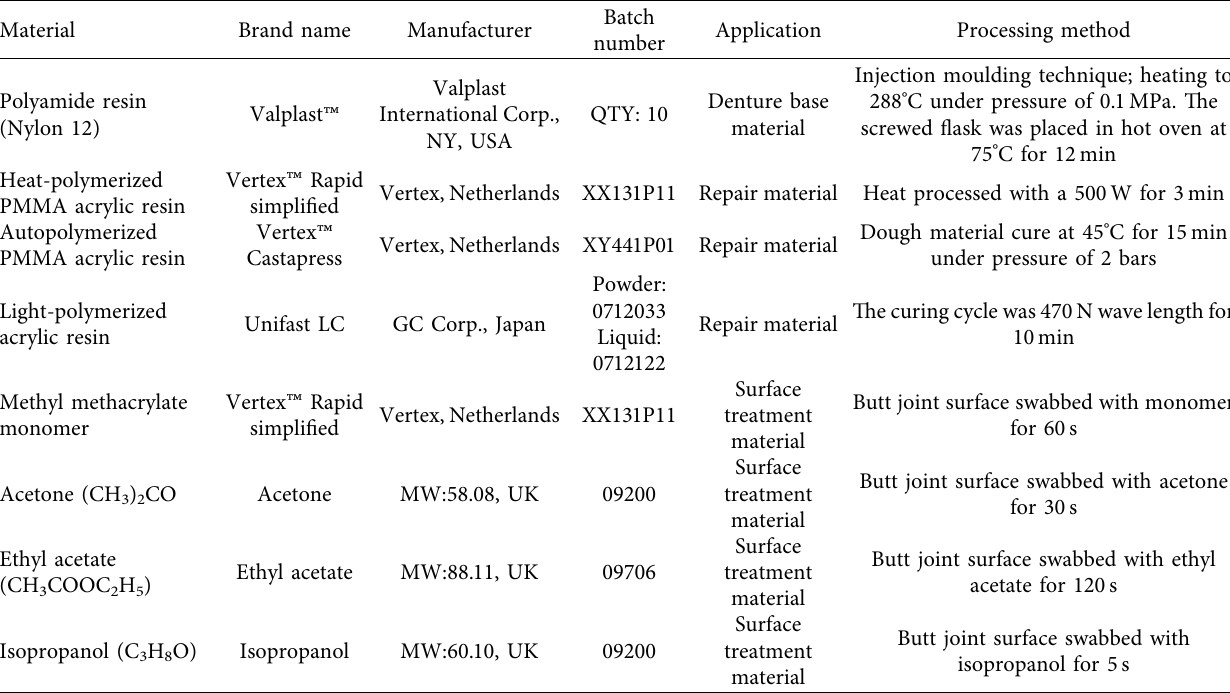
Table 1: Materials used in this